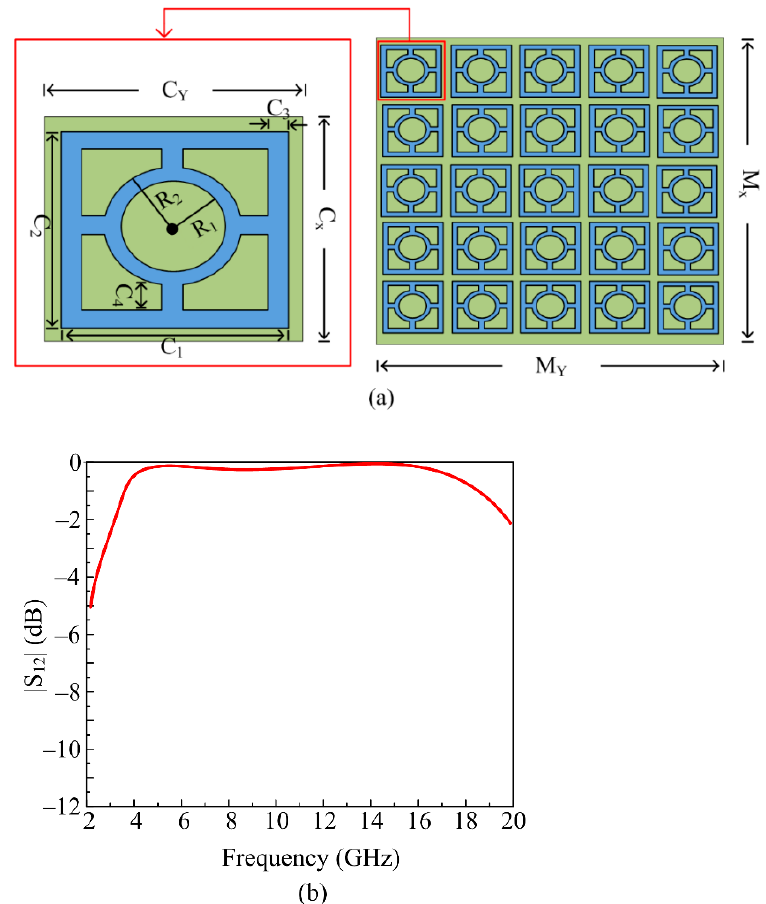
Figure 5. ( a ) Structure of proposed frequency selective surface (FSS) and unit cell dimensions; ( b ) |S 12 | property of suggested FSS unit cell. ( b ) |S 12 | property of suggested FSS unit